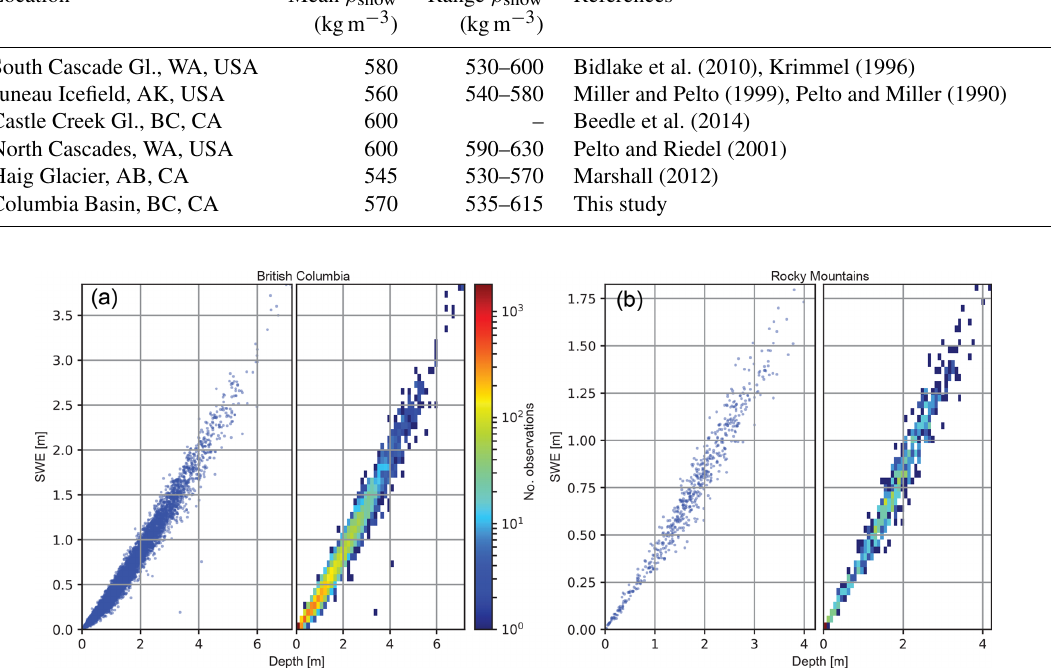
Figure 2. Snow depth versus snow water equivalent from 1 May provincial snow survey data. The mean date of our spring field seasons was 1 May, and so we chose 1 May BC snow survey data (a) to derive a SWE–snow-depth regression from which we determined the average 1 May snow density (470 ± 70kgm − 3 ( r 2 = 0 . 97, n = 10169)). For Haig Glacier, we derived a regression from only snow stations within the Rocky Mountains south of Pine Pass to derive winter density (440 ± 50kgm − 3 ( r 2 = 0 . 97, n =